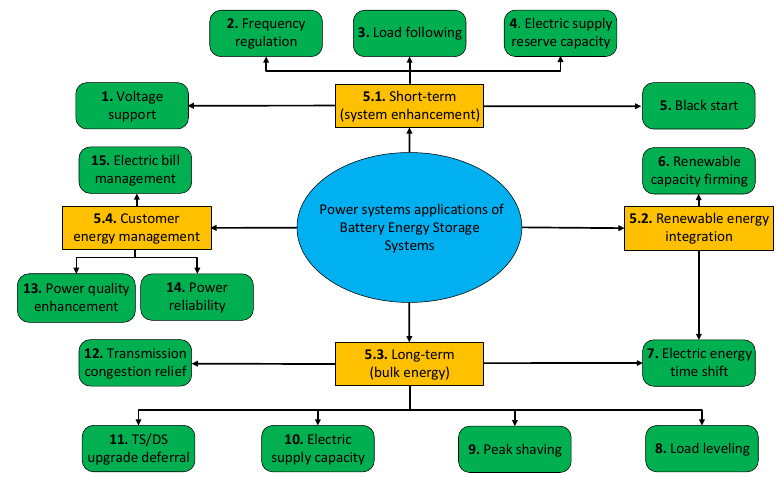
Figure 5. Classification of the ancillary services provided by BESSs connected to the transmission and distribution system in the